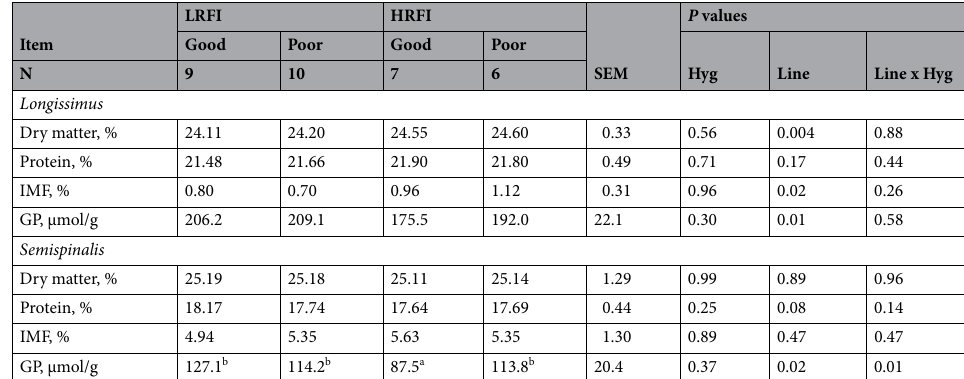
Table 2. Chemical composition of longissimus and semispinalis muscles of pigs divergently selected for low (LRFI) or high (HRFI) residual feed intake and raised in good or poor hygiene conditions (Hyg). Intramuscular fat (IMF) was expressed as percentage of fresh muscle and glycolytic potential (GP) as micromoles of equivalent lactate per gram of fresh muscle. Values are LS means. a,b Within a row, means without a common superscript differ (P < 0.05).